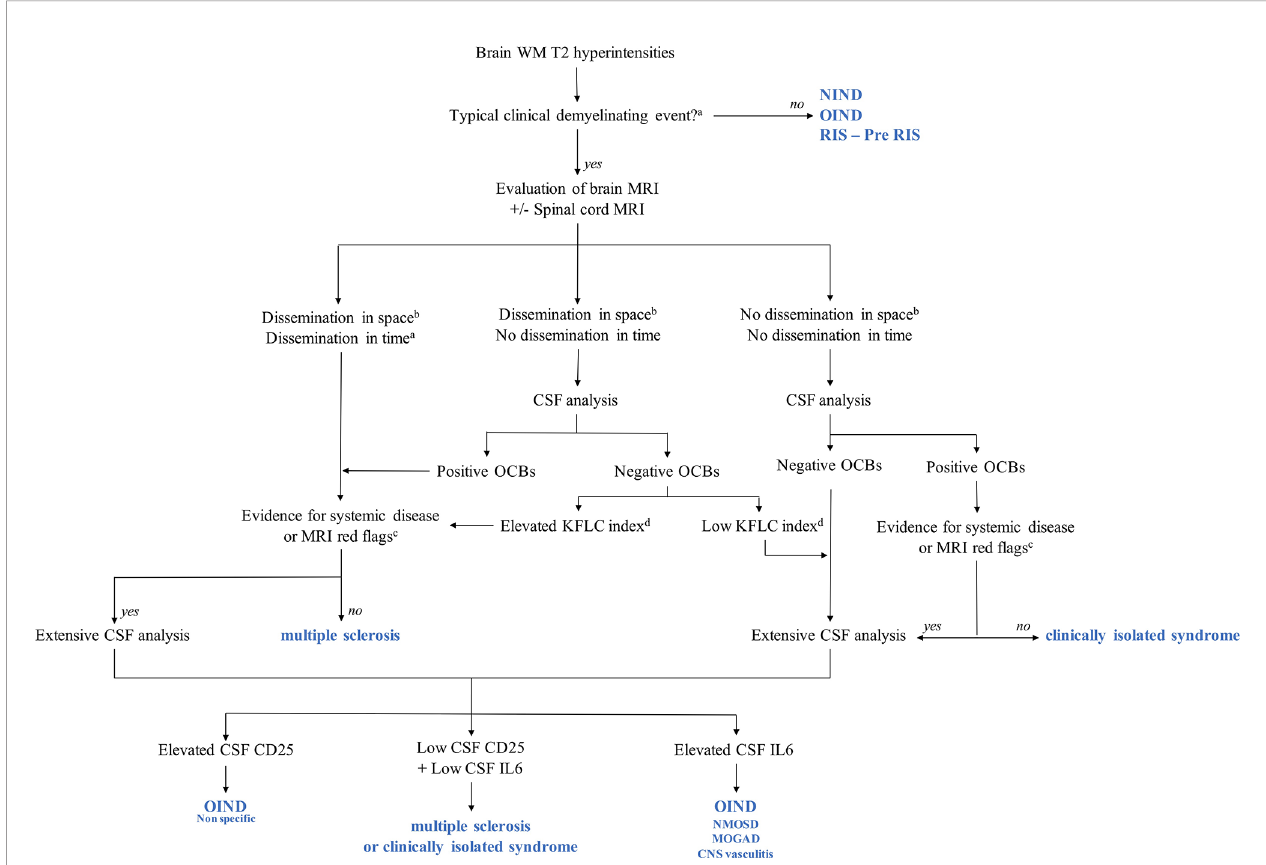
FIGURE 4 | Multiple sclerosis (MS) diagnostic algorithms including KFLC index, CSF CD25, and CSF IL-6. MOGAD, myelin oligodendrocyte glycoprotein antibody- associated disease; NIND, non-in fl ammatory neurological disorder; NMOSD, neuromyelitis optica spectrum disorder; OIND, other in fl ammatory neurological disorder; Pre-RIS, radiologically isolated syndrome with one or two speci fi c dissemination in space criteria; RIS, radiologically isolated syndrome; WM: white matter. a According to reference (1). b According to reference (37). c According to reference (38). d In our study, the KFLC index cutoff was 13.1. This cutoff is speci fi c to our cohort and should not be used in daily practice, while each MS tertiary center should determine its threshold values. KFLC, kappa free light chains; CSF, cerebrospinal fl